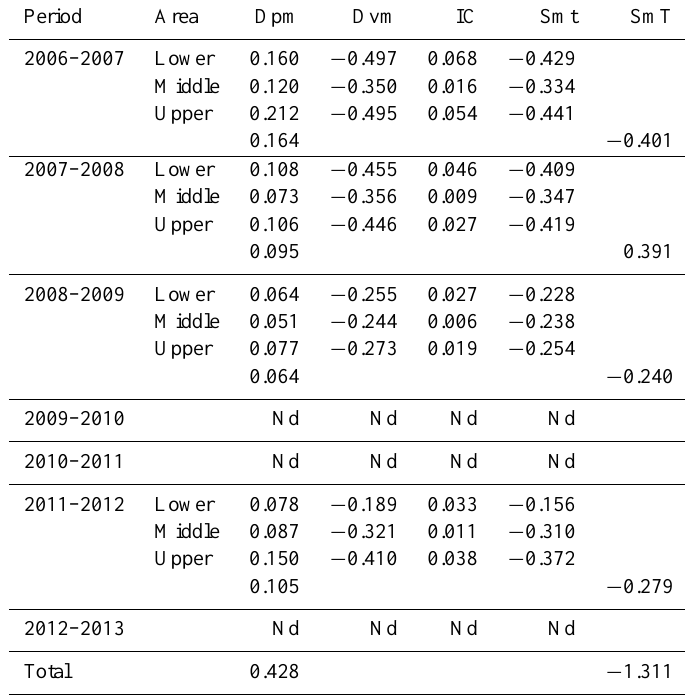
Table 2. Planar and vertical movements (2007–2013). Period